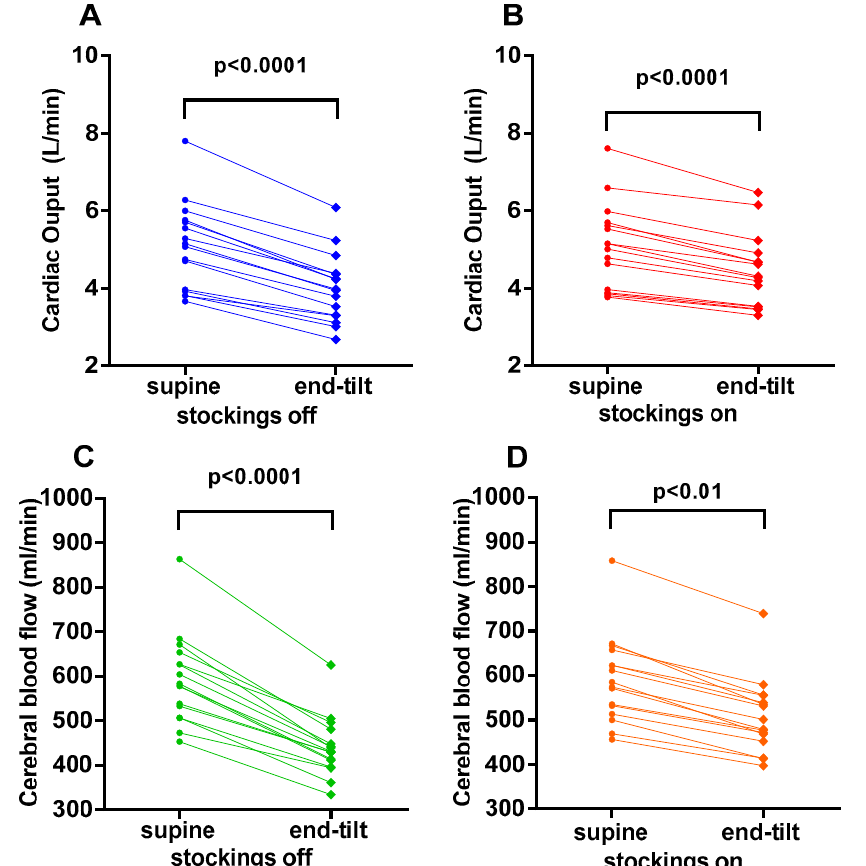
Figure 1. Cardiac output supine and end-tilt for compression stockings off (panel A ) and compression stockings on (panel B ). Cerebral blood flow supine and end-tilt for compression stockings off (panel C ) and compression stockings on (panel D